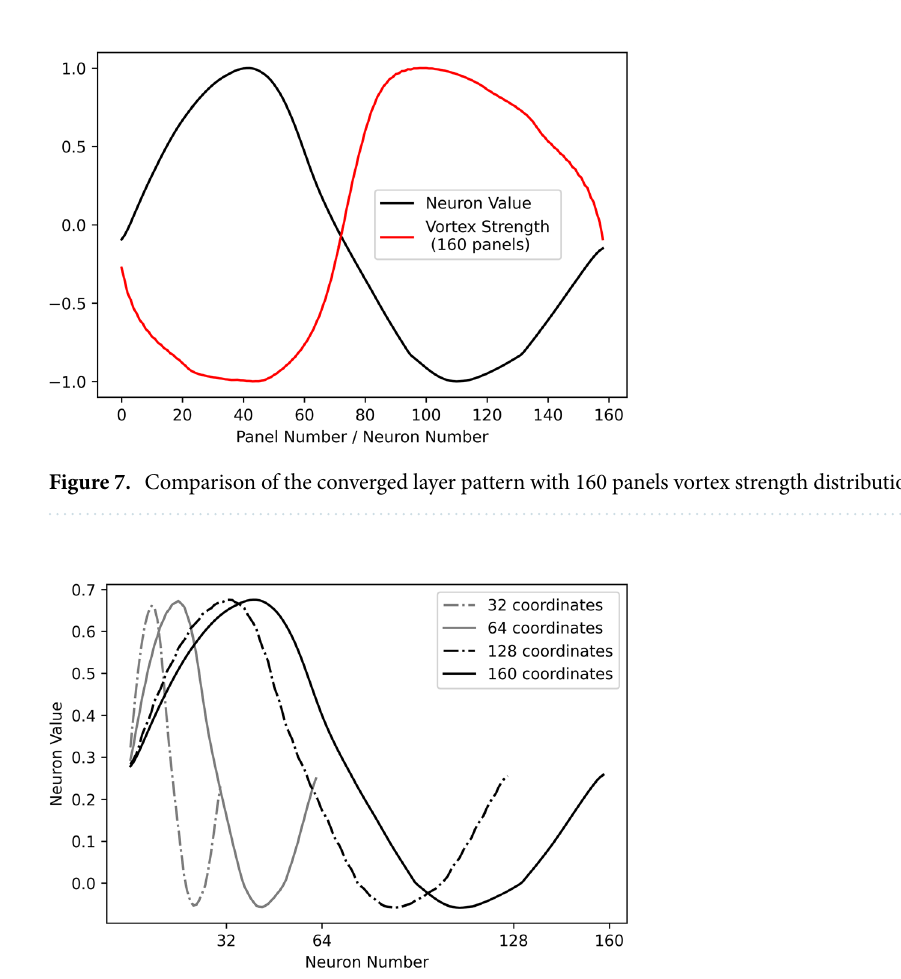
Figure 8. Neuron values of the fully connected layer with different number of airfoil